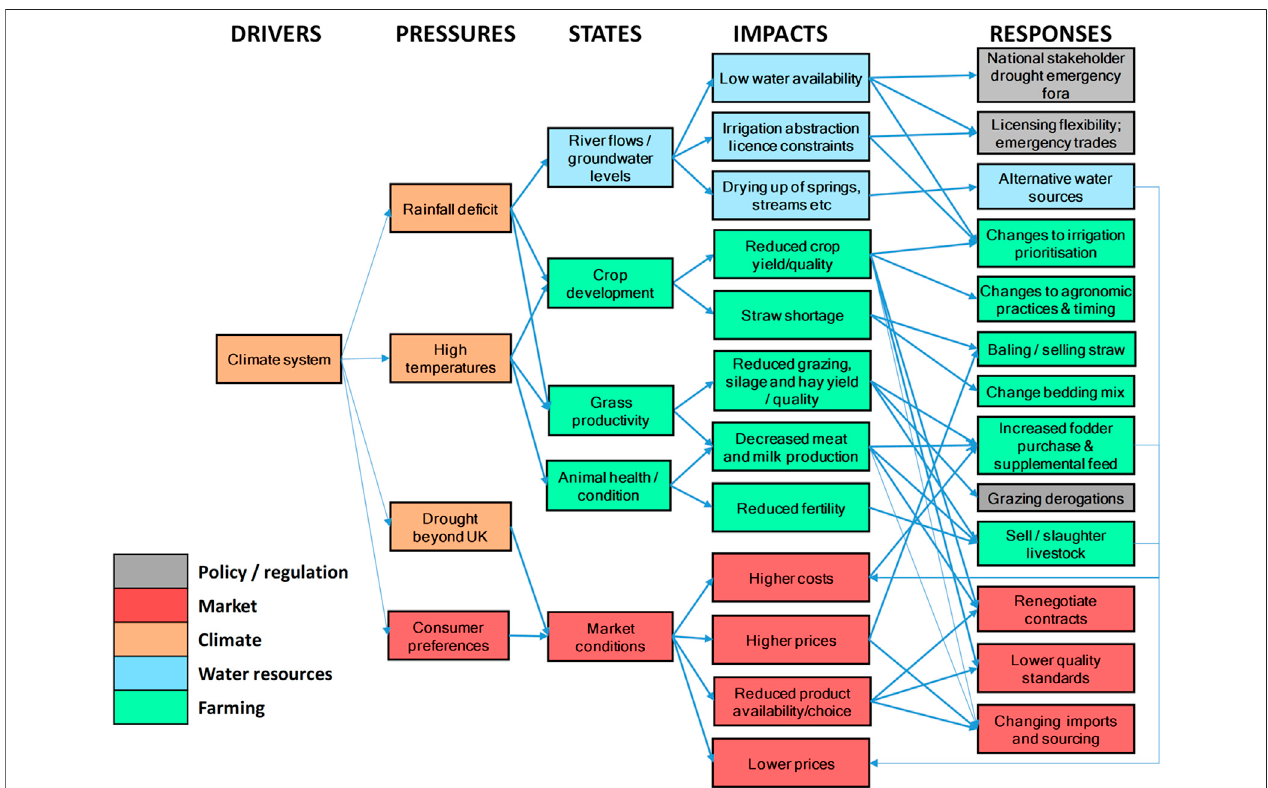
FIGURE 5 | Simpli fi ed Driver-Pressure-State-Impact-Responses schematic for agriculture, showing how drought impacts and responses are interconnected to a range of drought pressures both from within and outside the United Kingdom.